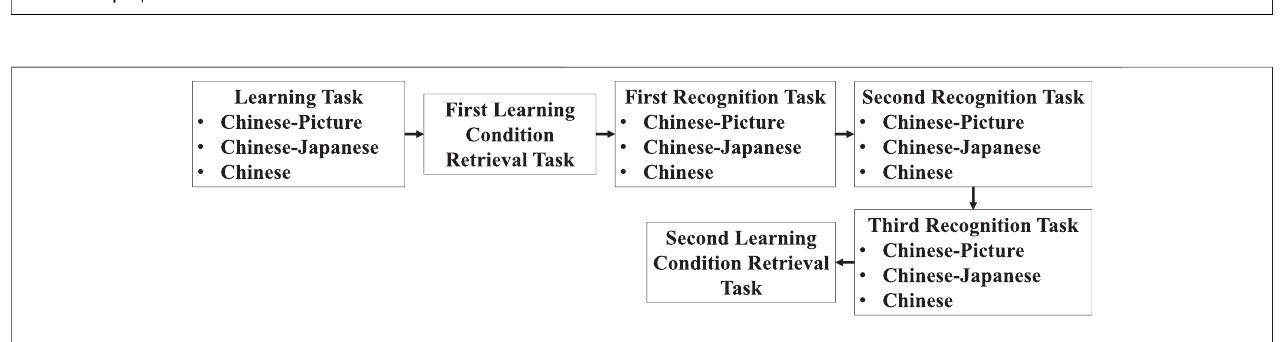
FIGURE 1 | Experimental tasks.